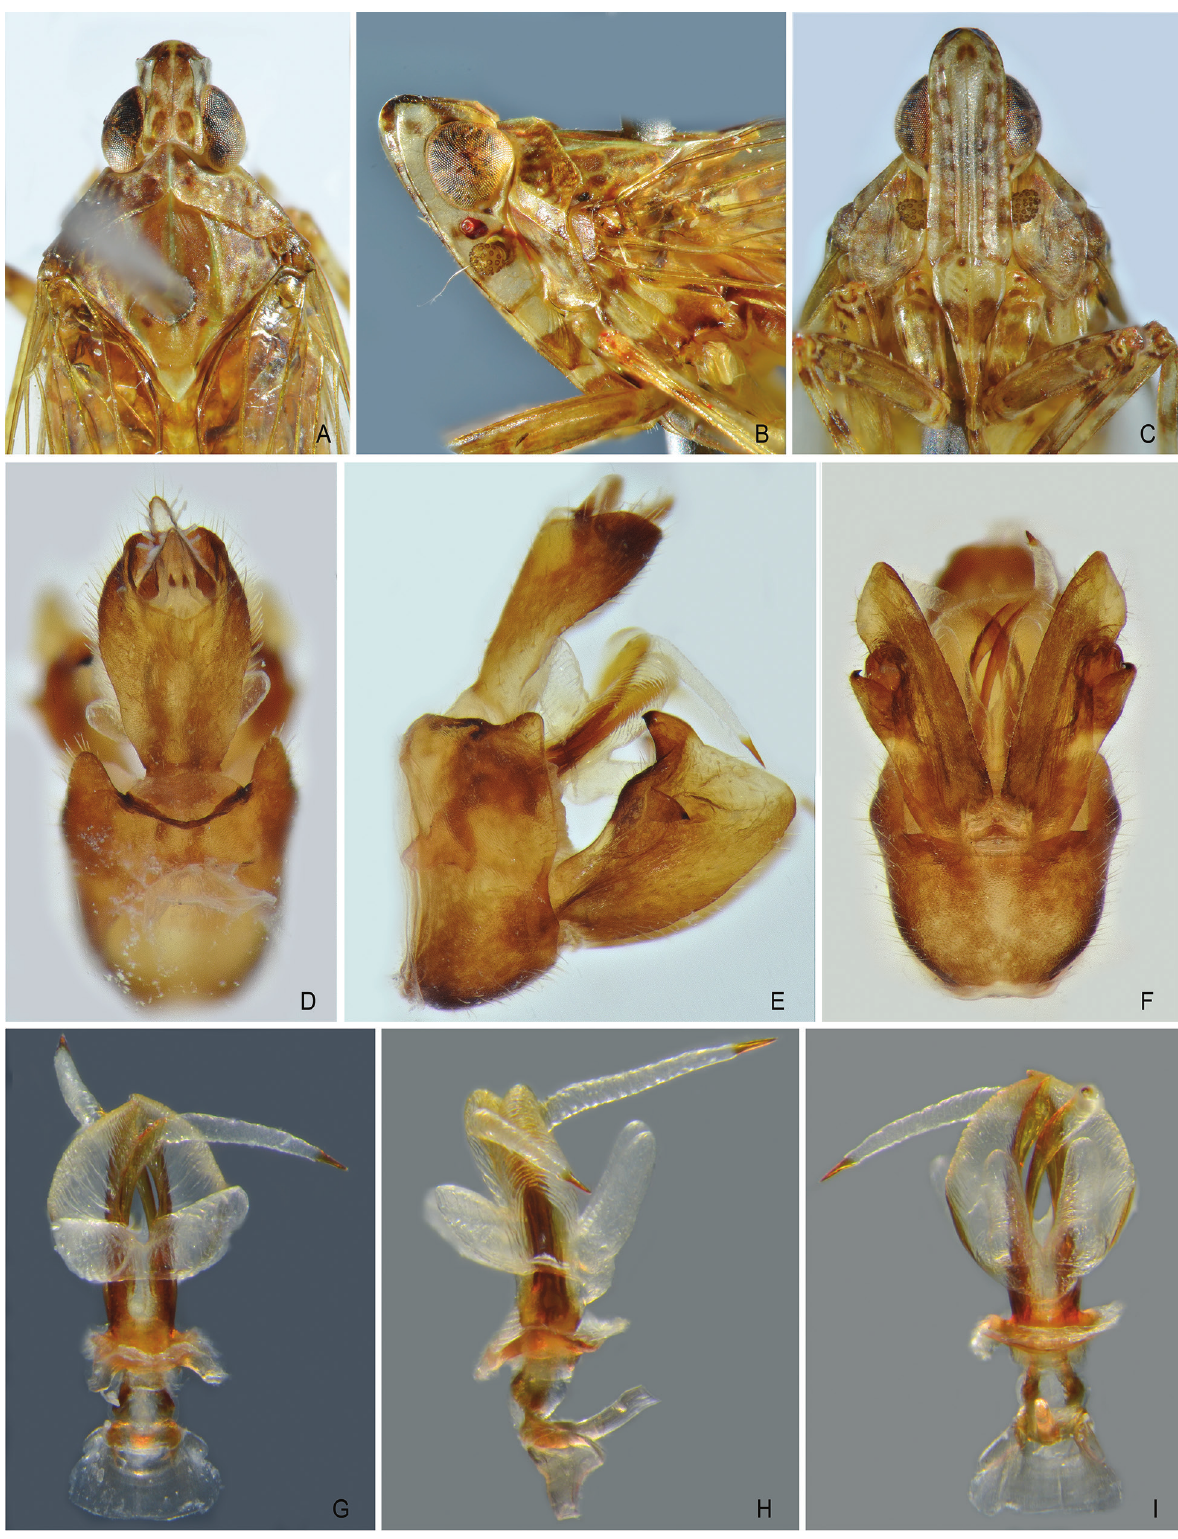
Figure 5. Orthopagus exoletus (Melichar). ( A ) Head, pronotum and mesonotum, dorsal view. ( B ) Head and pronotum, lateral view. ( C ) Head and pronotum, ventral view. ( D ) Male segment X and pygofer, dorsal view. ( E ) Male pygofer, gonostyles, and segment X, lateral view. ( F ) Male pygofer and gonostyles, ventral view. ( G ) Aedeagus, dorsal view. ( H ) Aedeagus, lateral view. ( I ) Aedeagus, ventral